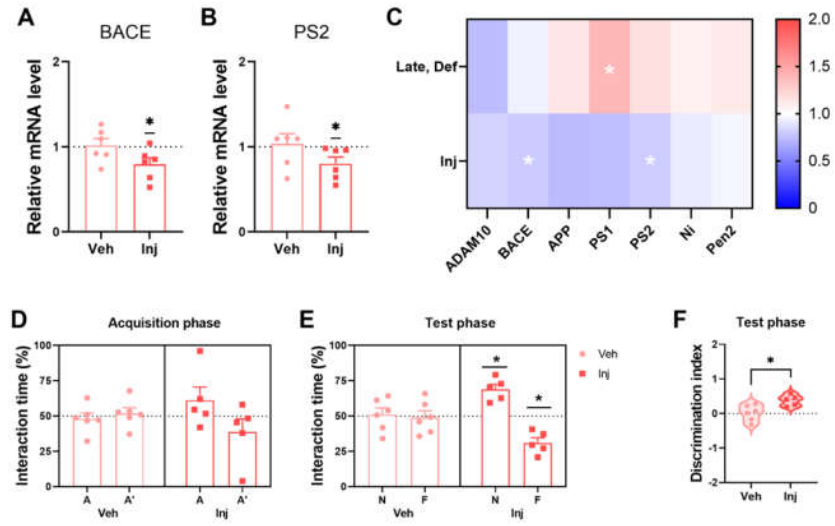
Figure 3. Vitamin D supplementation in the late stage decreased the Aβ load in AD model mice. ( A ) Experimental scheme of the vitamin D-supplemented state induced by the intraperitoneal injection of vitamin D in 5xFAD mice. At 4.5 months old, Veh ( n = 6) and Inj ( n = 6) group mice were administered vitamin D or saline, respectively. ( B ) The total A β 42 levels in the cortex, hippocampus, and pons of the ~7-month-old Veh and Inj groups were measured using ELISA kits. ( C ) The soluble and ( D ) insoluble A β 42 levels are also shown. Dots represent the data on individual mice in each group. The data are presented by the mean ± SEM of each group. * p < 0.05 and ** p < 0.01 by the Student’s t -test.